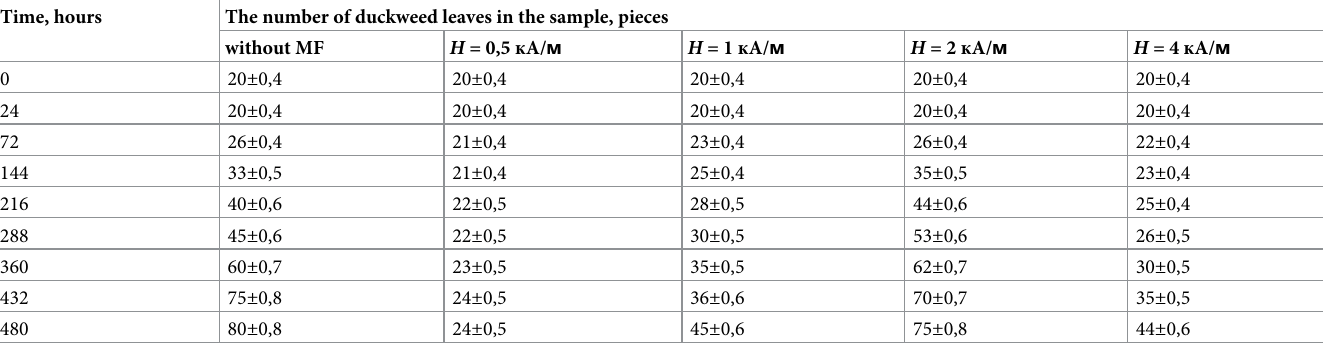
Table 1. Dynamics of Lemna minor duckweed breeding with and without MF. Time,